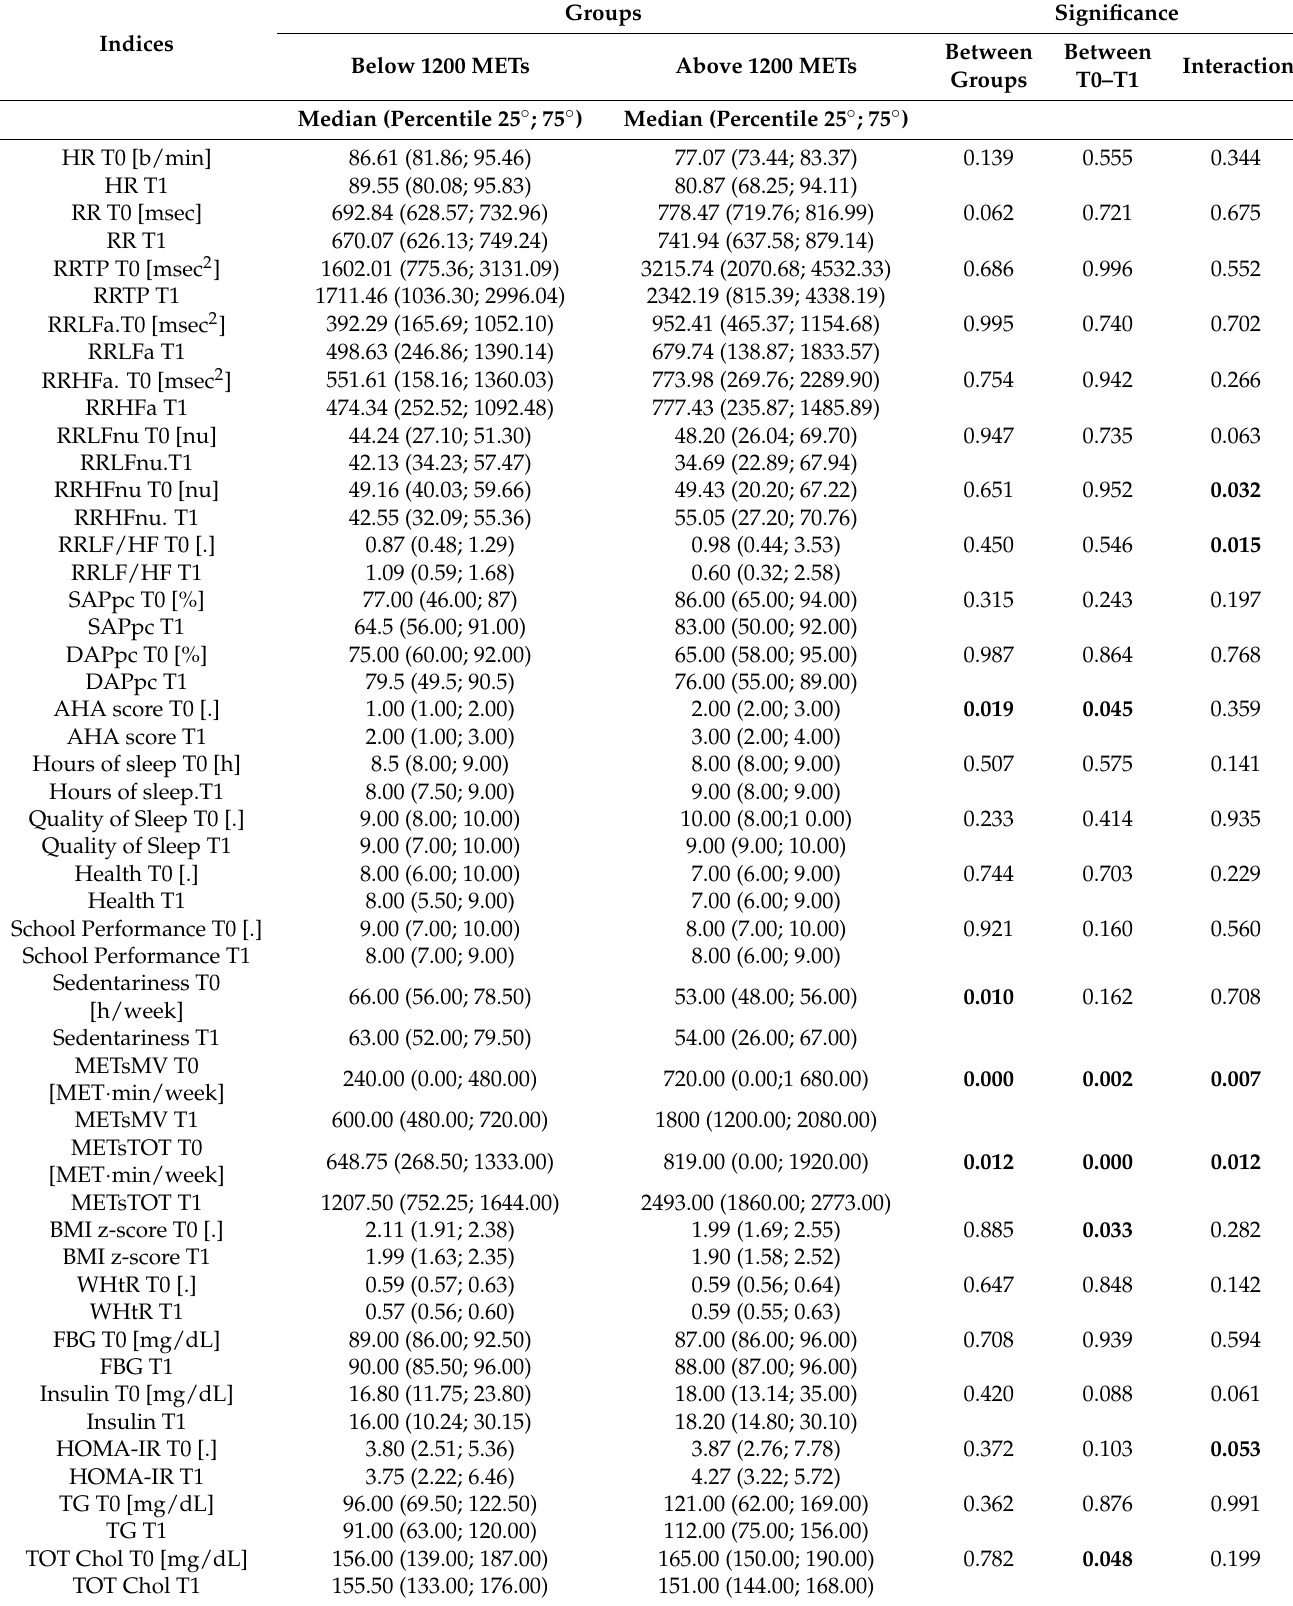
Table 2. Summary of descriptive data of the study population subdivided into two groups considering weekly volume of structured exercise (METsMV) (Subdivision